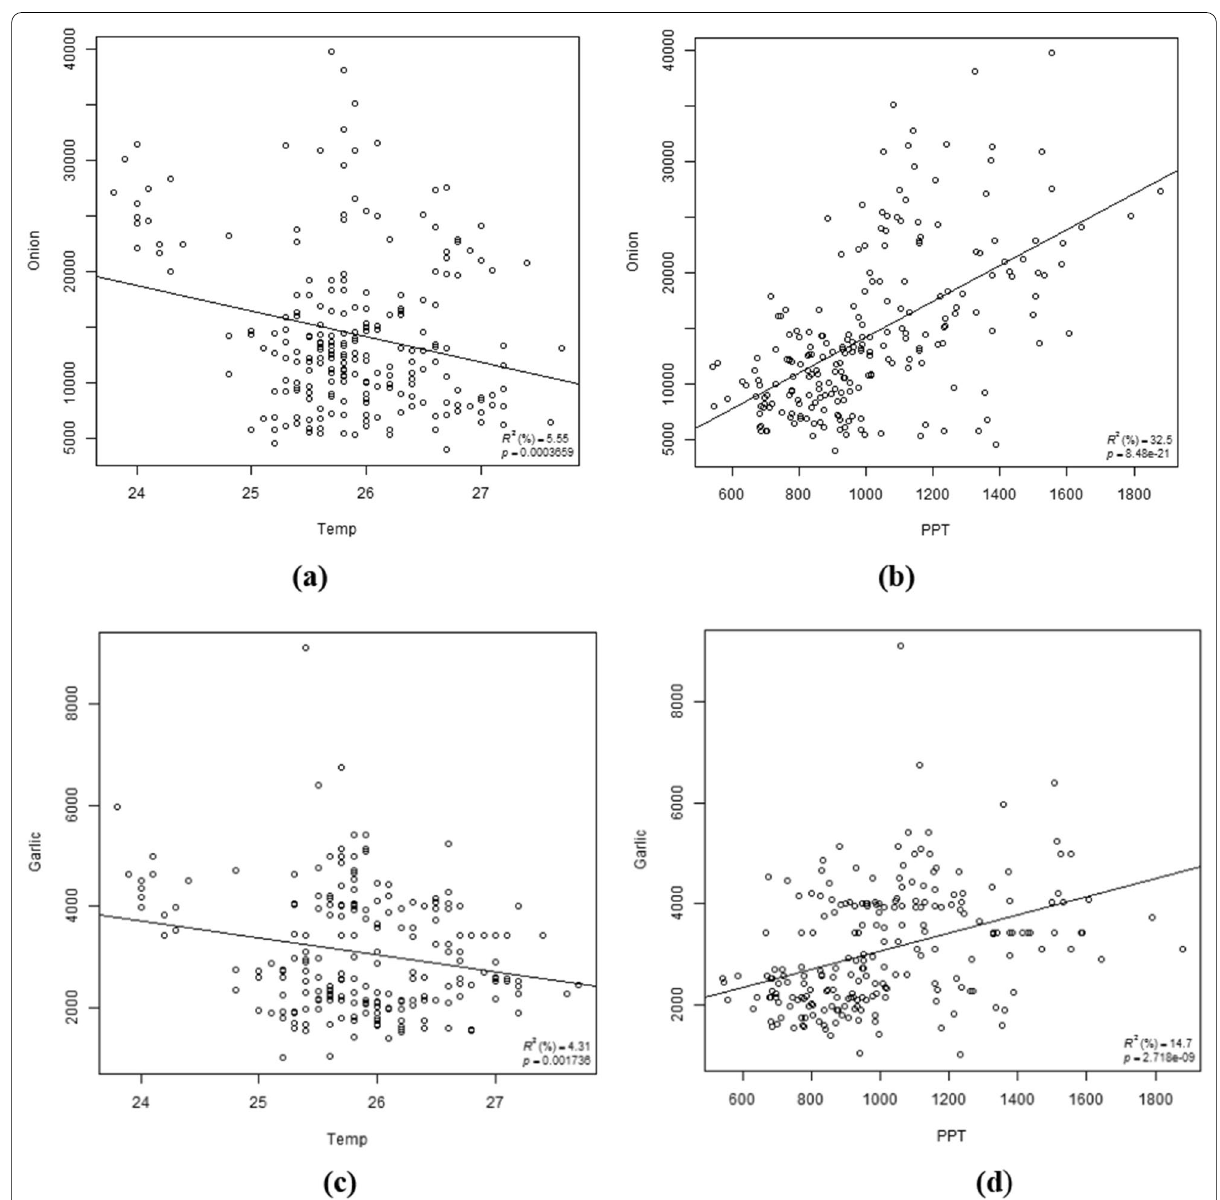
Fig. 23 Scatter diagram of the linear regression analysis of a onion yield with temperature, b onion yield with precipitation, c garlic yield with temperature, d garlic yield with precipitation, e chillies yield with temperature, f chillies yield with precipitation, g potato yield with temperature, h potato yield with